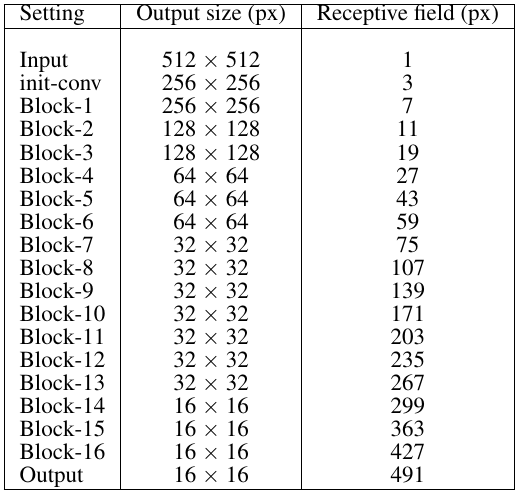
Table 1. Block-wise receptive fields and block output size for